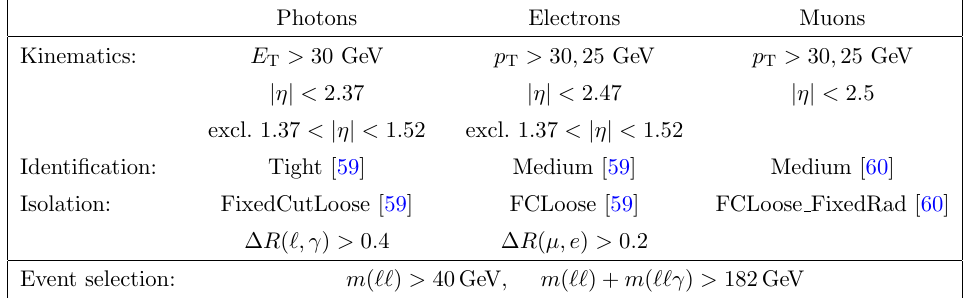
Table 2 . De(cid:12)nition of the ‘ + ‘ (cid:0) (cid:13) signal region. The selection criteria for photons and leptons are presented in the upper part of the table, while the event-level selection criteria are presented in the bottom row. For the lepton p T requirements, the (cid:12)rst (second) number speci(cid:12)es the minimum allowed p T of the lepton with the highest (second-highest) value of transverse